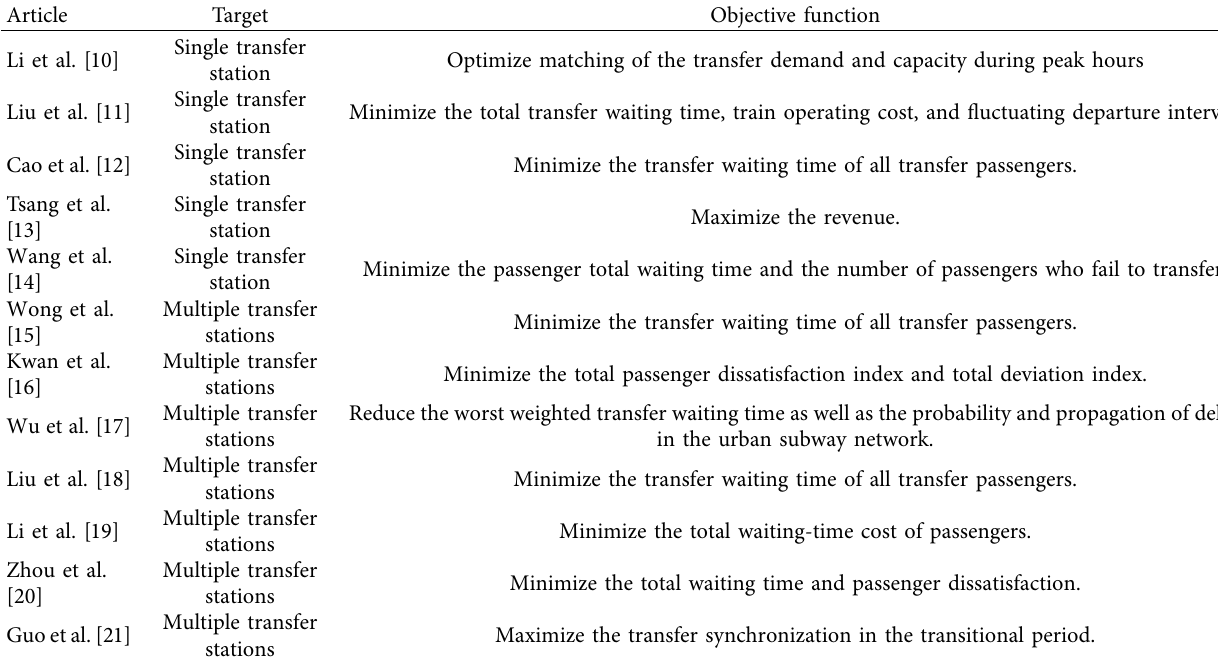
Table 1: Comparison of timetable synchronization